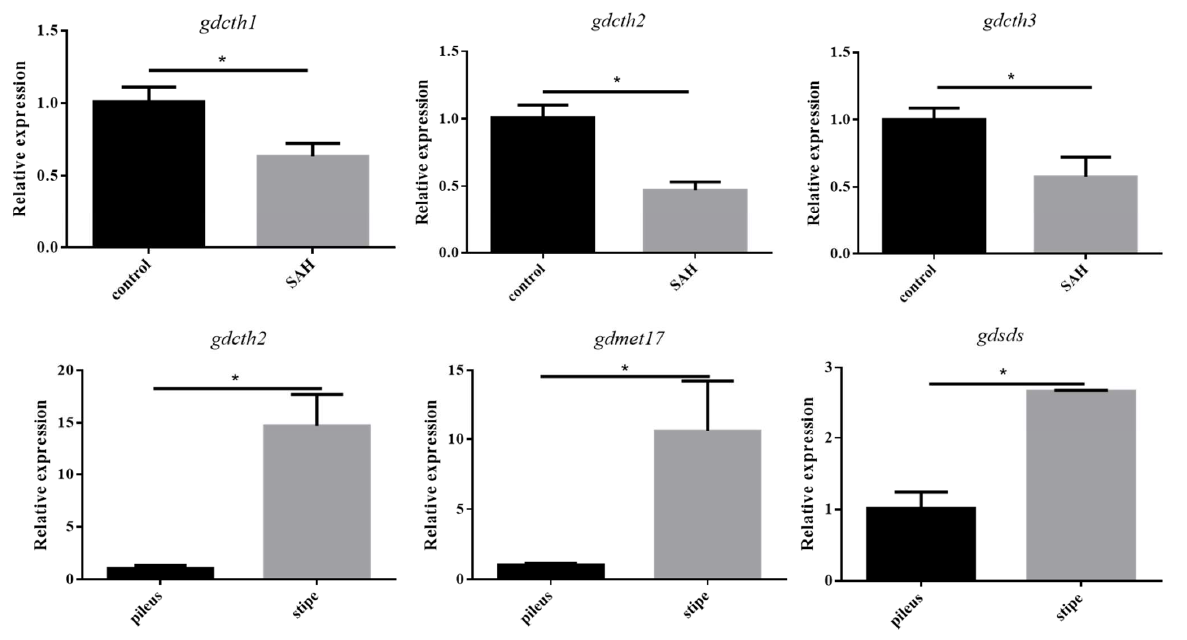
Figure 8. Validation of transcript expression changes by qRT-qPCR (Paired t-test, * indicated p < 0.05).